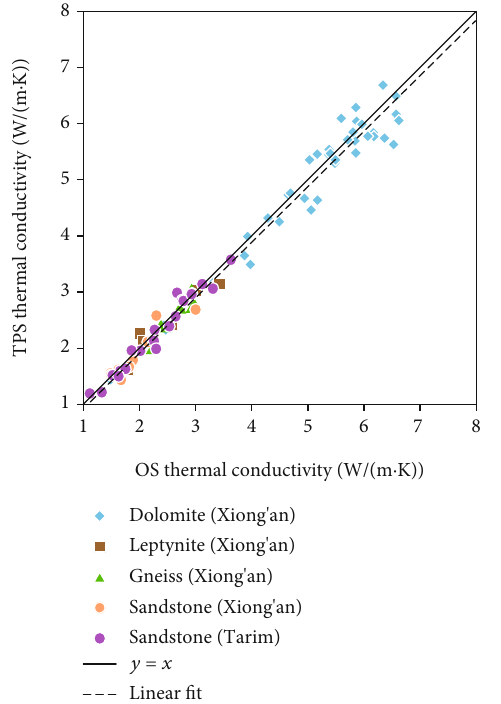
Figure 9: Comparison of thermal conductivity of dry samples measured by TPS and OS